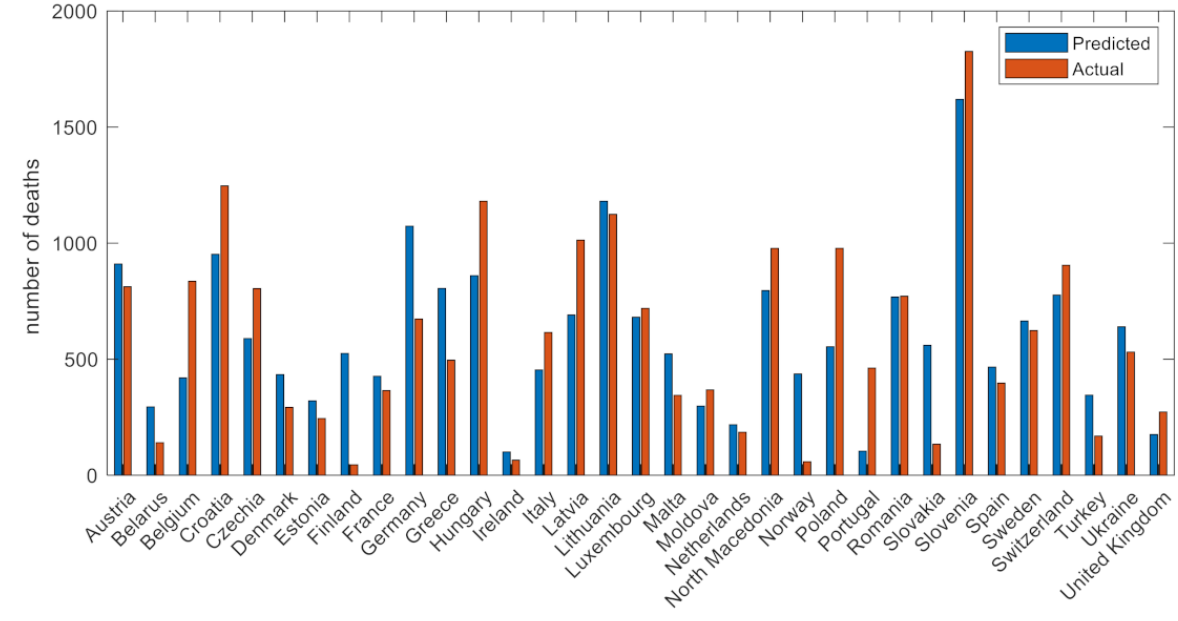
Figure 6. Actual versus predicted number of deaths in wave